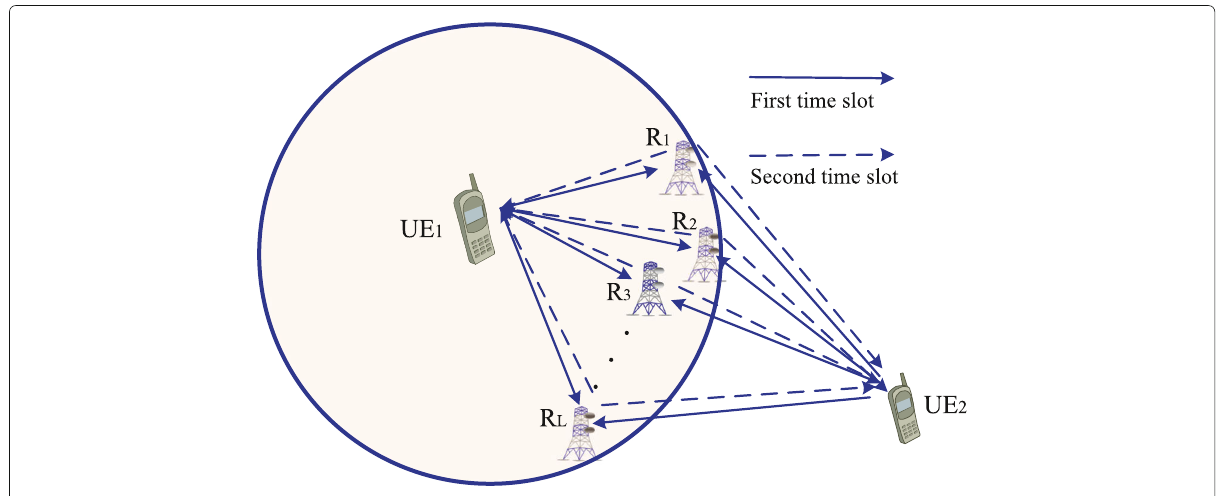
Fig. 1 Two-way MIMO multi-relay